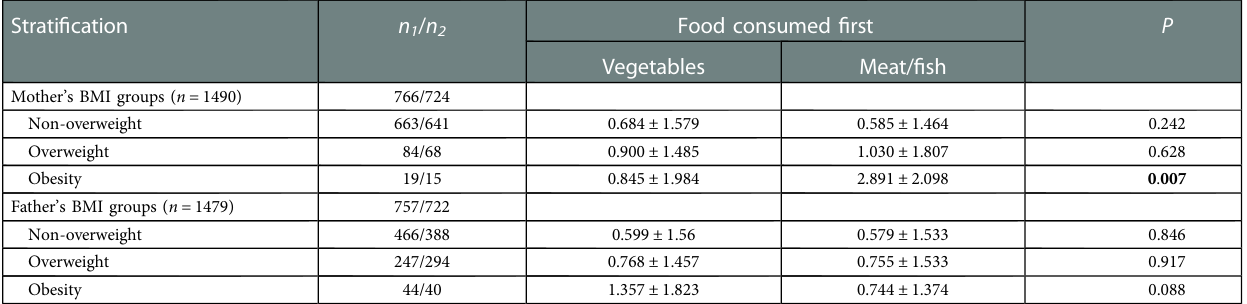
TABLE 3 Differences in BMI z-score between children who consumed vegetables fi rst and those consumed meat/ fi sh fi rst at a meal, strati fi ed by parental weight status. Strati fi cation n 1 / n 2